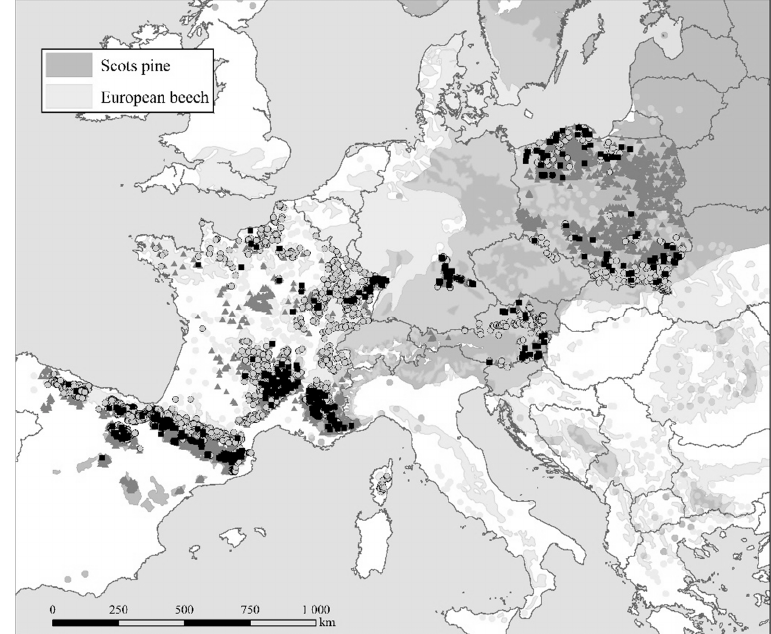
Figure 1. Location of the sample plots in monospecific pine stands (dark grey triangles), and monospecific beech stands (light grey circles) and mixtures of both species (black squares) used in this study together with the natural range of both tree species according to EUFORGEN [49]. Table 1. Summary of the plot data (pine, beech, and mixtures of both species) used in this study. Note that a small number of stems of other species may be present in monospecific or mixed stands. Pine